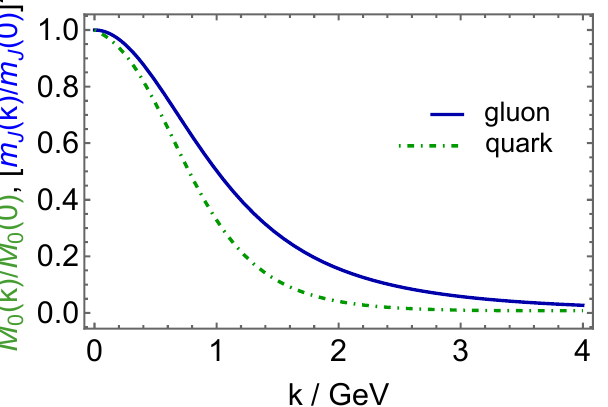
Figure 2. Renormalisation-group-invariant dressed gluon mass function (solid blue curve) calculated, following the method in Reference[72], from a gluon two-point function obtained using the lQCD configurations in References[73–75]. The mass-squared curve is plotted, normalised by its k = 0 value, and compared with the kindred chiral-limit dressed quark mass function drawn from Reference[76] (dotted-dashed green curve). It is this pair of curves that is 1/ k 2 -suppressed in the ultraviolet, each with additional logarithmic